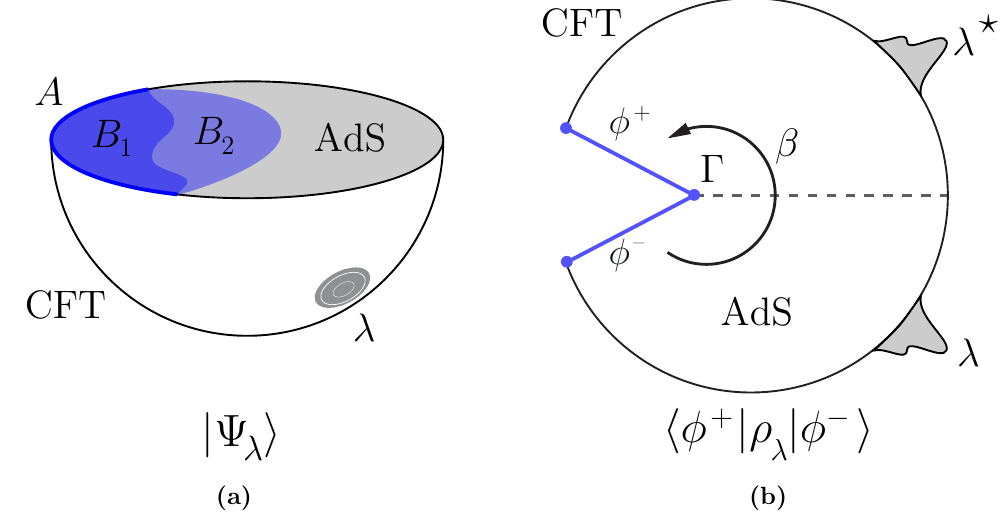
Figure 2. (a) A representation of the state external source (cid:21) = 0 prepares an excited state. The CFT subsystem A is denoted in blue, while 6 two candidates for its dual bulk regions are denoted B 1 and B 2 . (b) A depiction of the computation of (cid:30) + (cid:26) (cid:21) (cid:30) (cid:0) is shown, where (cid:26) (cid:21) = Tr (cid:22) h j j i branches and (cid:12) is the local angle between them around the codimension-2 surface (cid:0) inside the